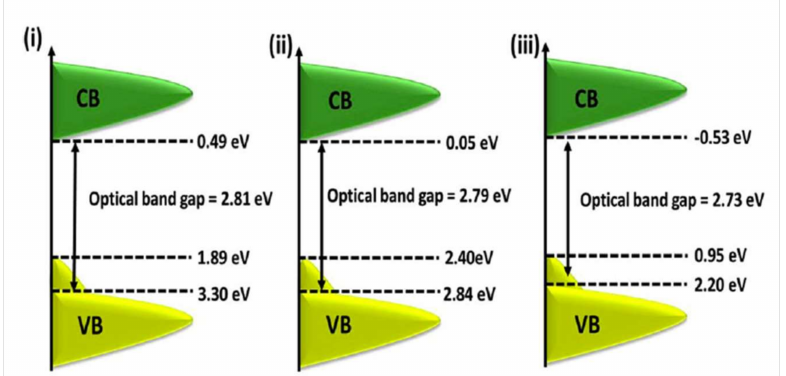
Figure 11. Proposed density of electronic states (DOS) for ( i ) SnO 2 , ( ii ) 1 at% Ni–SnO 2 , and ( iii ) 5 at% Ni–SnO 2 NPs. Reproduced with permission from Ref. [130]. Copyright 2020 Elsevier.